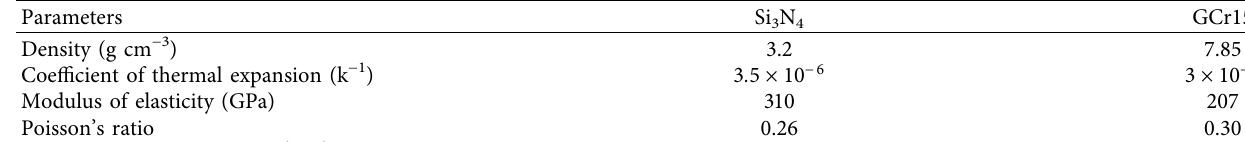
Table 3: Material parameters of the bearing.